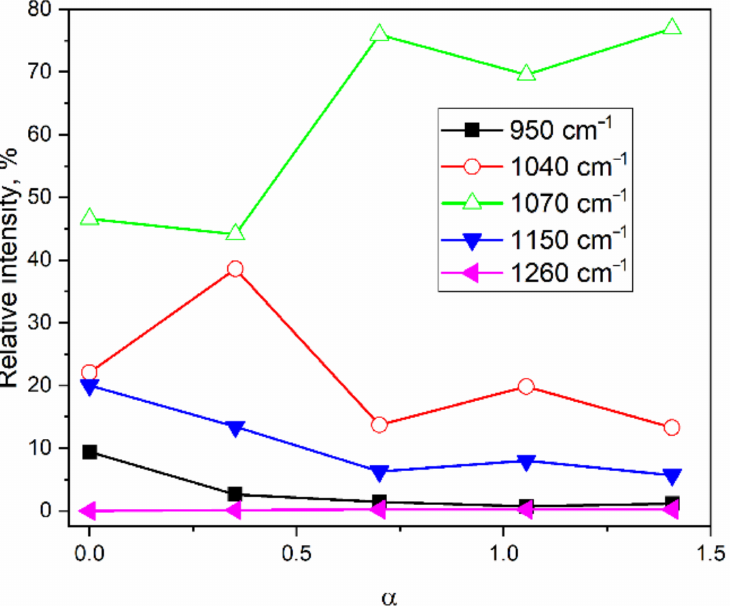
Figure 3. The relative area of the IR-bands band of samples in the region of the Si-O-Si and Si- OH